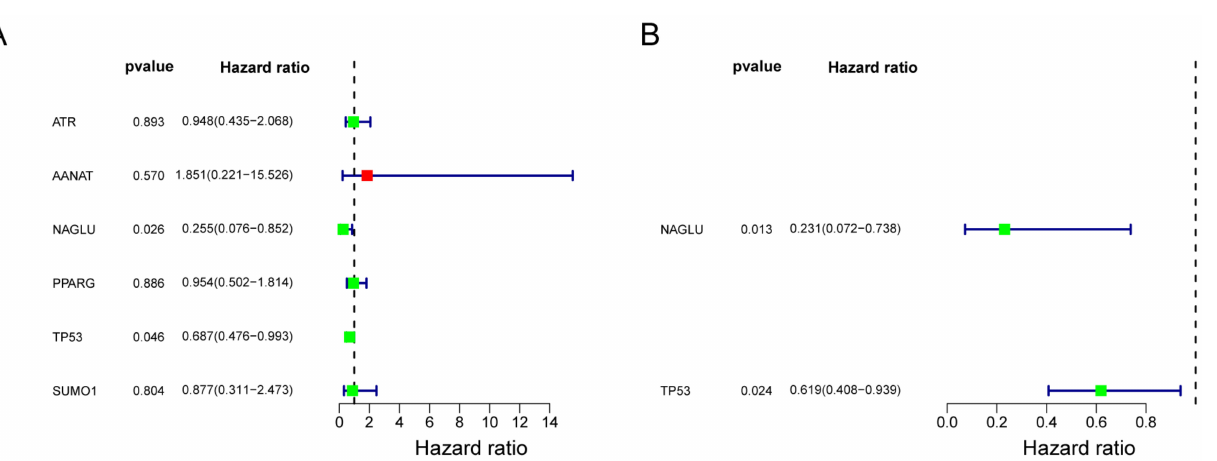
Figure 2. Risk model constructed with Cox regression analysis. ( A ) Forest plot for univariate analysis. ( B ) Forest plot for mutivariate Cox regression analysis. Green: Hazard ratio (HR) < 1; red: HR > 1. Table 2. Descriptions of CCGs of the risk score model in Cox proportional hazard regression analysis. ID